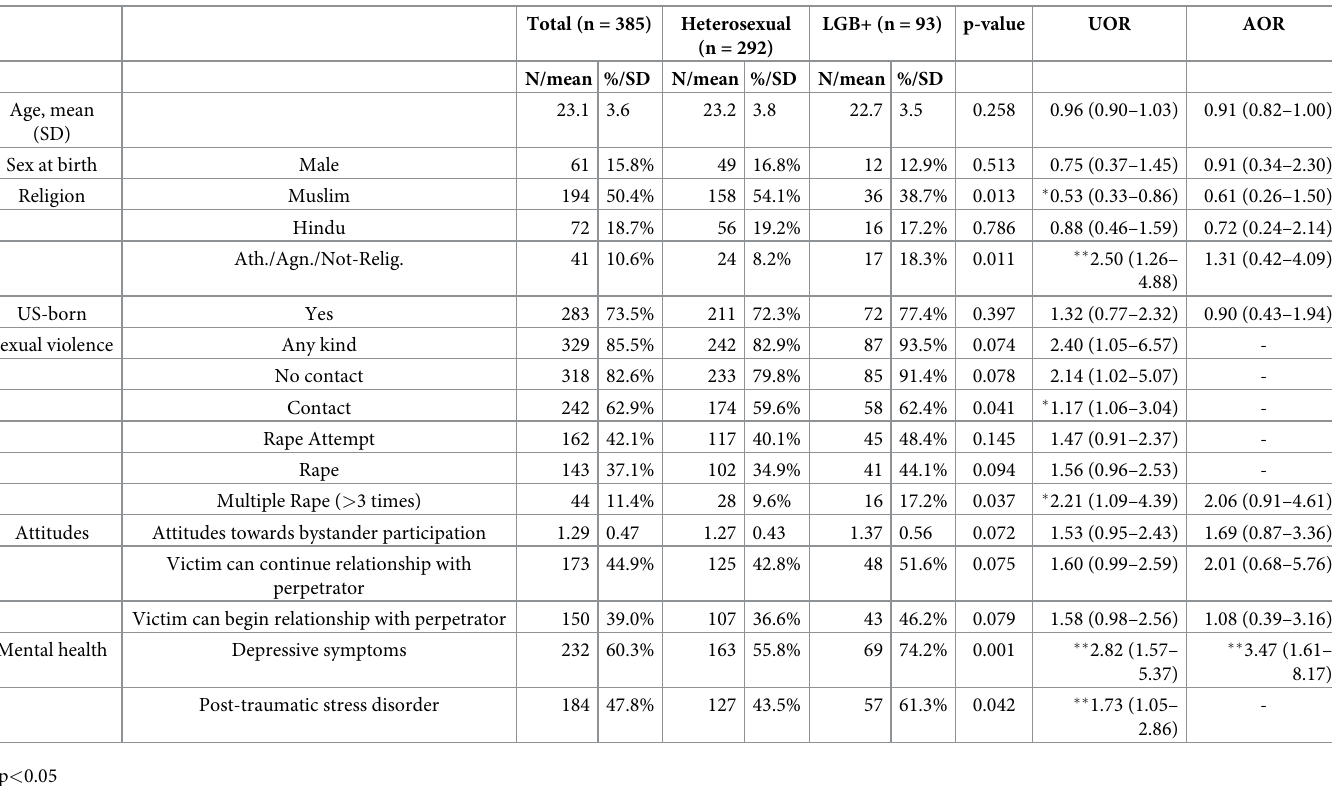
Table 1. Characteristics and significant sexual assault related disparities among sample of South Asian young adults stratified by sexual minority status (N =